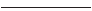
the item 4.1 more difficult than its calibrated value. For this group of students, the items 4.1 and 8.2 had roughly equal popularities. We inferred that these students were unfamiliar with the concept of energy band